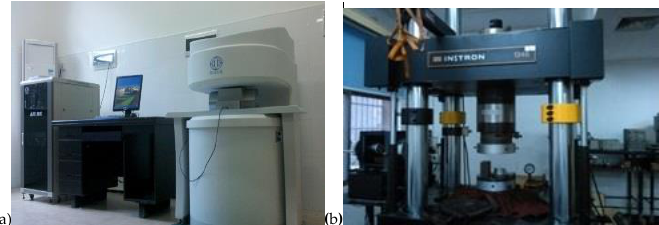
Figure 2. Test apparatus ( a ) low-field NMR system and ( b ) a uniaxial compressive strength testing machine.